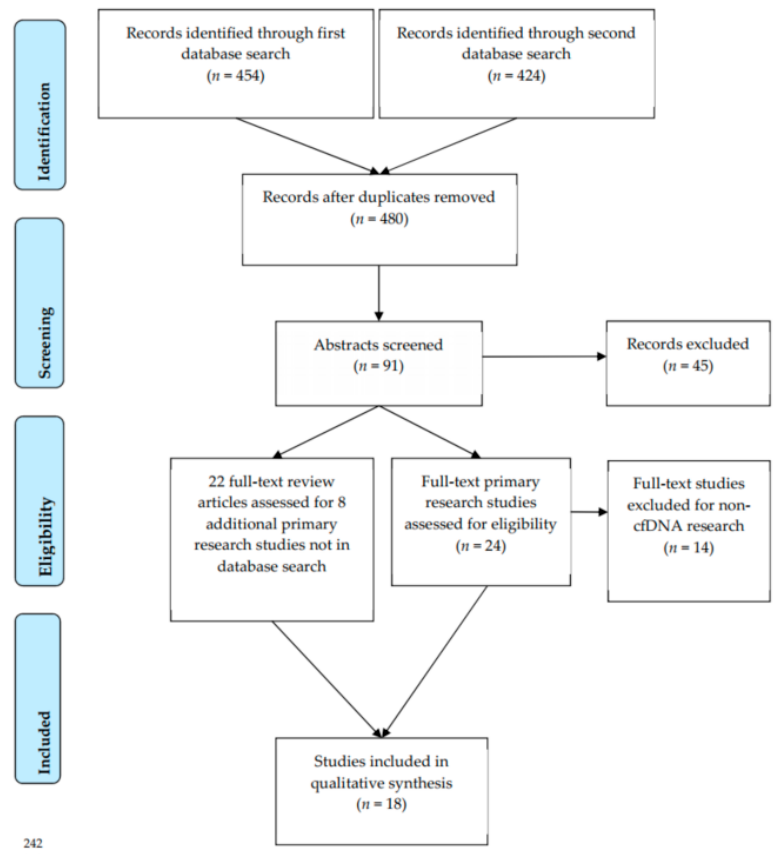
Figure 1. PRISMA flow diagram.